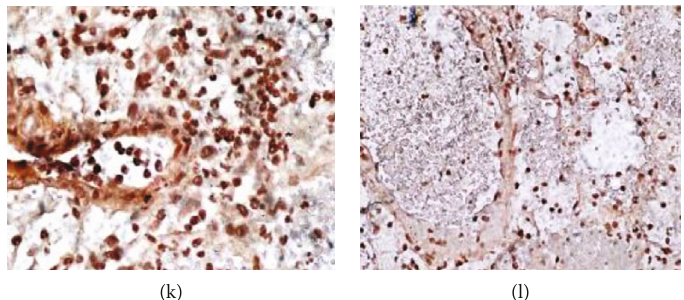
Figure 4: Masson ’ s trichrome staining, immunohistochemistry, and the fl uorescence microscopy of the lung section after ARDS modeling and treatment. (a, b) LPS and LPS+dexamethasone groups. The intense blue staining of collagen fi bers surrounding the bronchi and alveolar vessels. (c) Blue staining of collagen fi bers in the lung interstitium. Masson ’ s trichrome staining × 800. (d) LPS+HPMSC group. Slight blue coloration of collagen fi bers around the vessels. Masson ’ s trichrome staining × 200/800. Observation period one week. (e – h) LPS+HPMSC group. HPMSCSs labeled with the PKH26 fl uorescent dye on the sections of lung tissue. (e) At 24 hours after their intratracheal injection; H&E staining × 800. (f) Fluorescence microscopy; observation period 24 hours. Magni fi cation × 800; (g, h) Fluorescence microscopy. Observation period 96 hours. Magni fi cation × 800; (i, j) LPS group. α -SMA-positive cells appeared in the area of fi brotic lesions. Magni fi cation × 400/800 (dark brown staining); (k) LPS+dexamethasone group. Intensive staining of α -SMA-positive cells. Magni fi cation × 400; (l) LPS+HPMSC group. Weak α -SMA immunostaining signal. Magni fi cation × 400. Observation period one